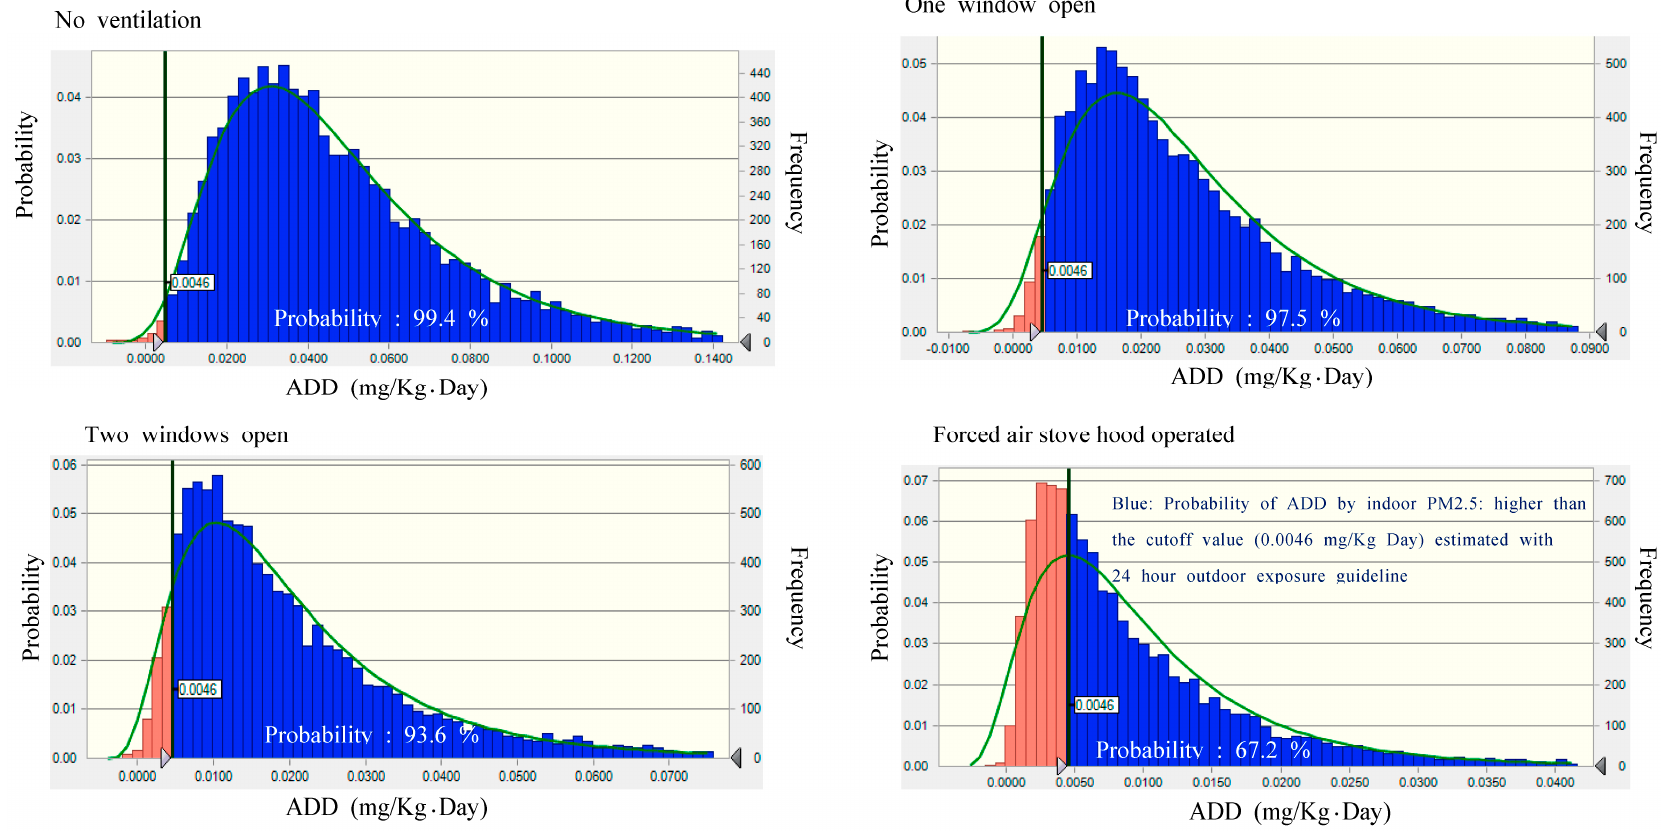
Figure 3. Distribution of average daily dose obtained from Monte Carlo simulation with the distribution of indoor PM 2.5 levels observed under different ventilation conditions, and the probability of ADD by indoor PM 2.5 which was higher (Blue) than the ADD (0.0046 mg/kg · day) estimate for roadside PM 2.5 .